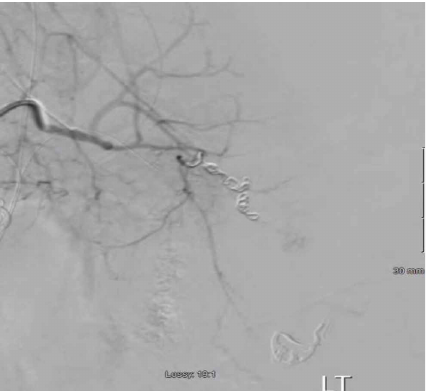
Figure 2: Angiogram, post embolization of the distal splenic artery with no evidence of